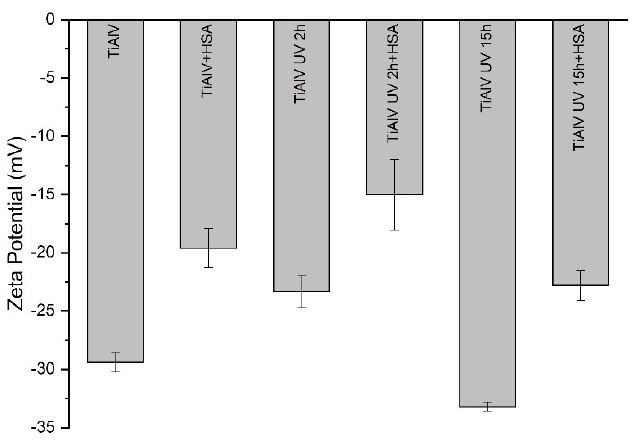
Figure 4. Zeta potential values for different surfaces, with different treatments, with and without adsorbed protein layer.